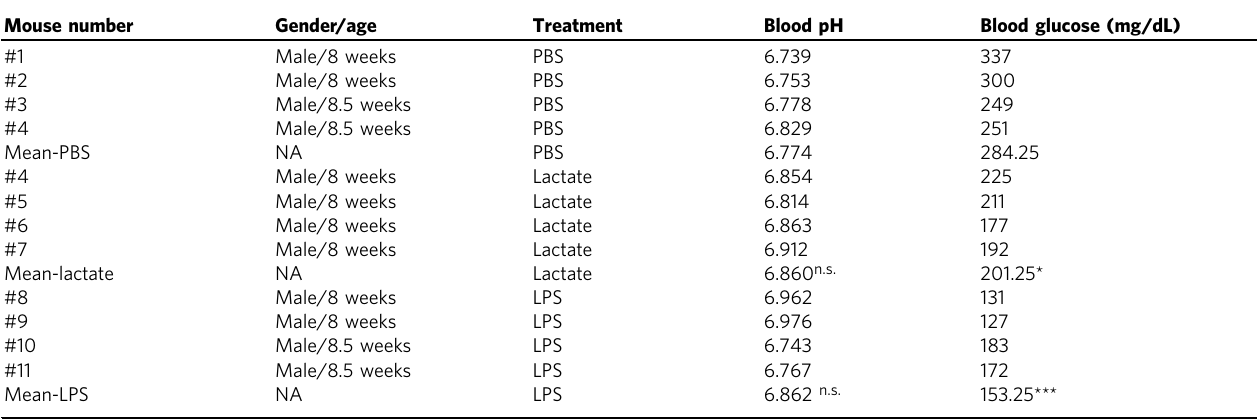
Table 1 Effects of lactate or LPS treatments on blood pH and glucose levels in WT mice. Mouse number Gender/age Treatment